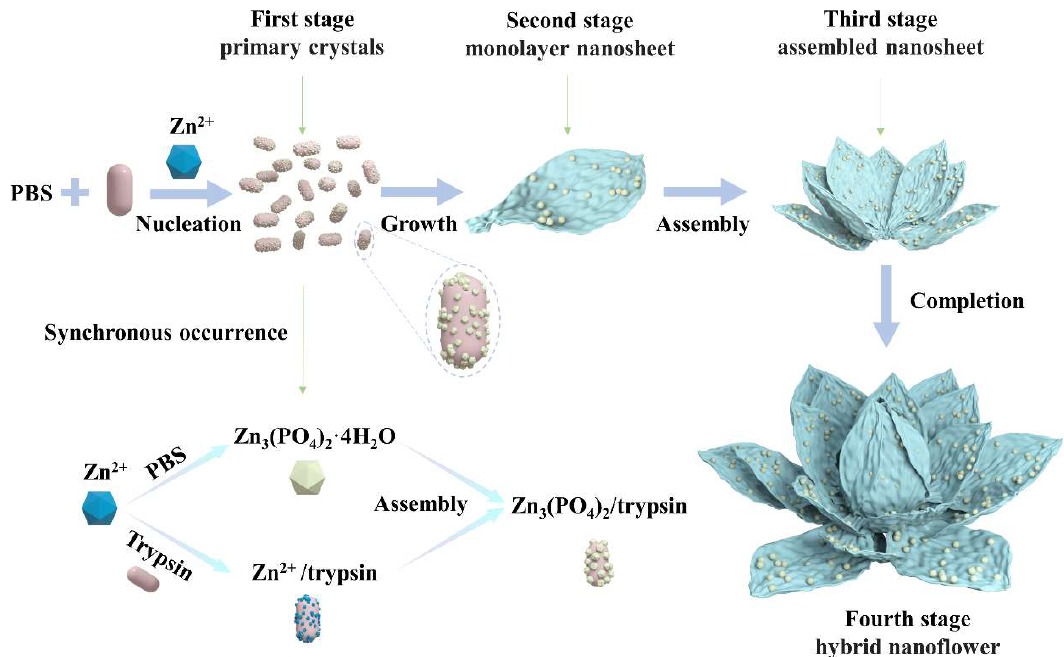
Figure 5. Formation of trypsin/Zn 3 (PO 4 ) 2 hybrid nanoflowers.